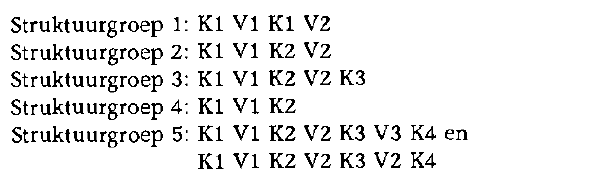
spraakfoute wat voorgekom het by die vyf proefpersone.